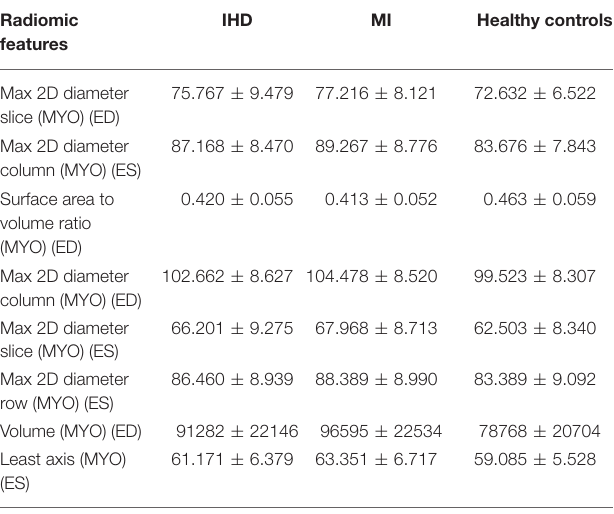
TABLE 3 | Selected top-ranked most discriminative shape features for IHD and MI compared to healthy controls. Radiomic